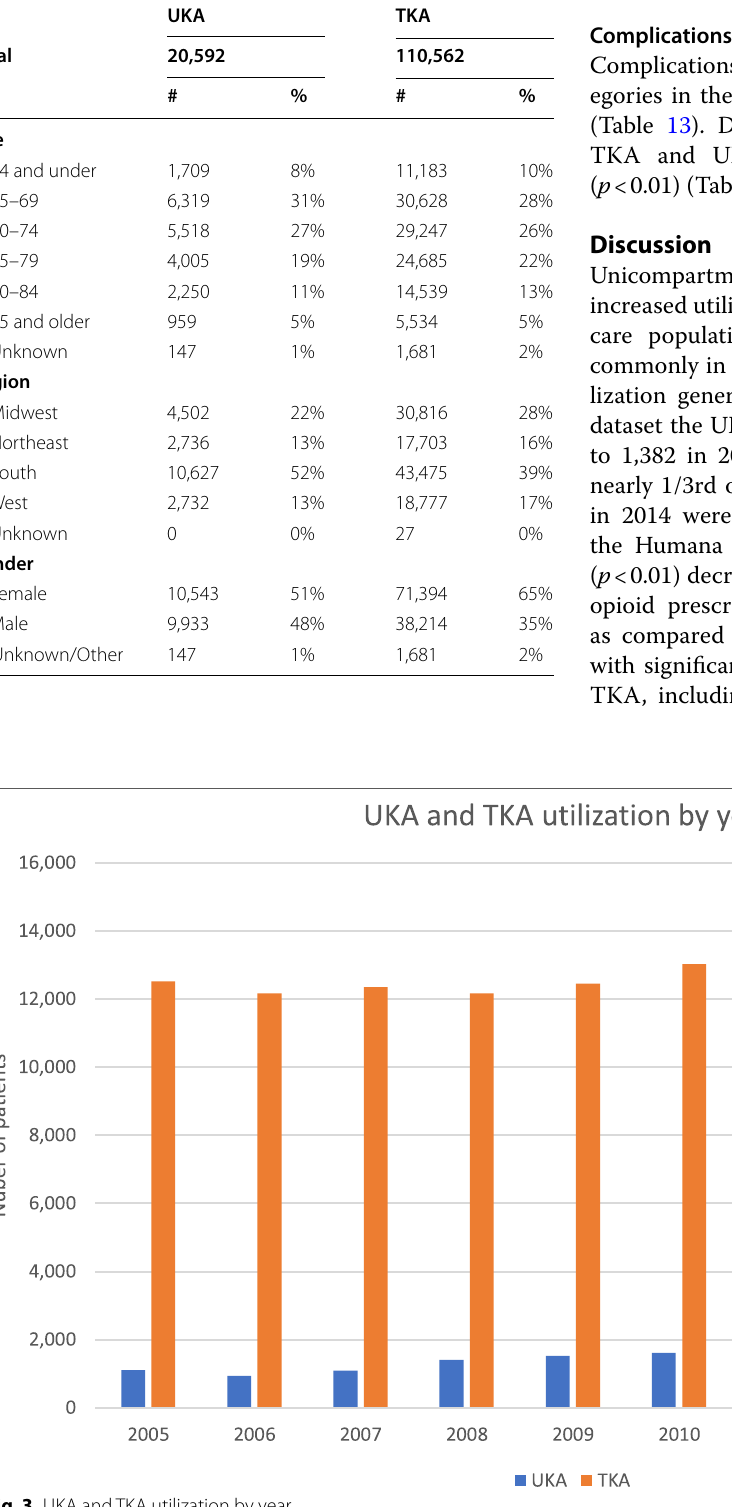
Fig. 3 UKA and TKA utilization by